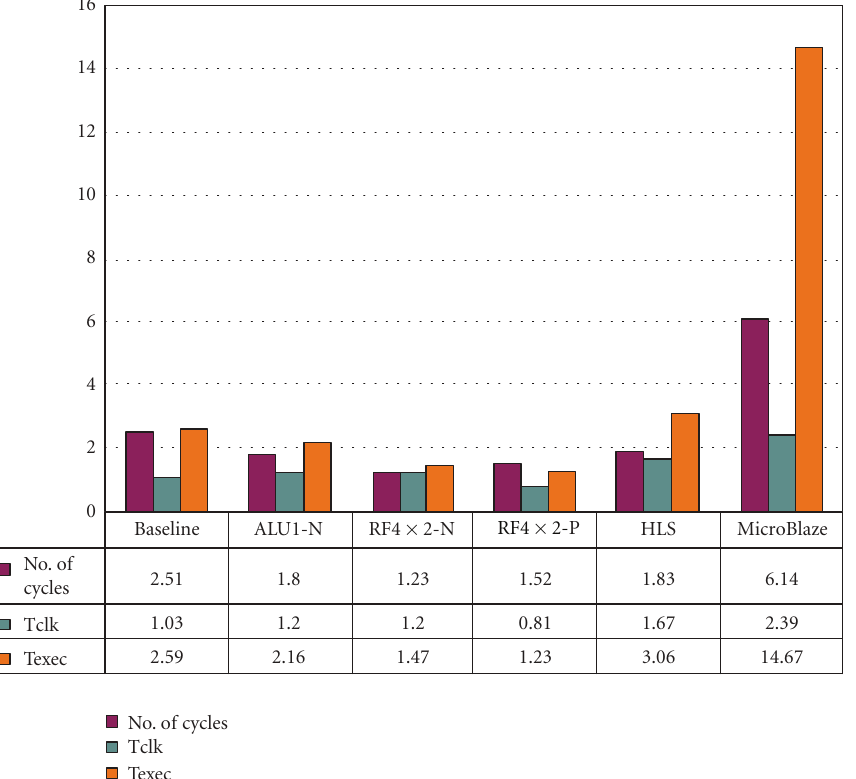
Figure 20: Performance comparison for dct32 relative to manual